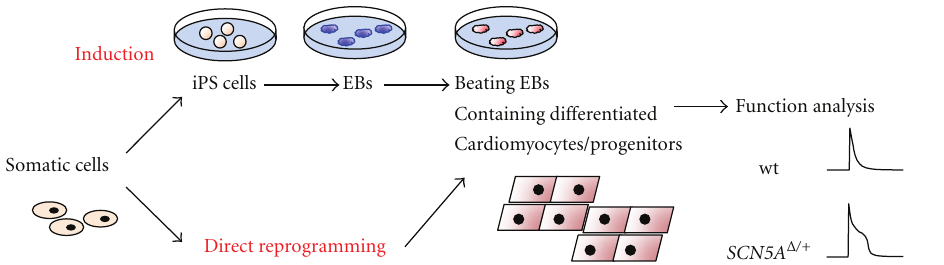
Figure 2: The methodology for in vitro cardiomyocyte di ff